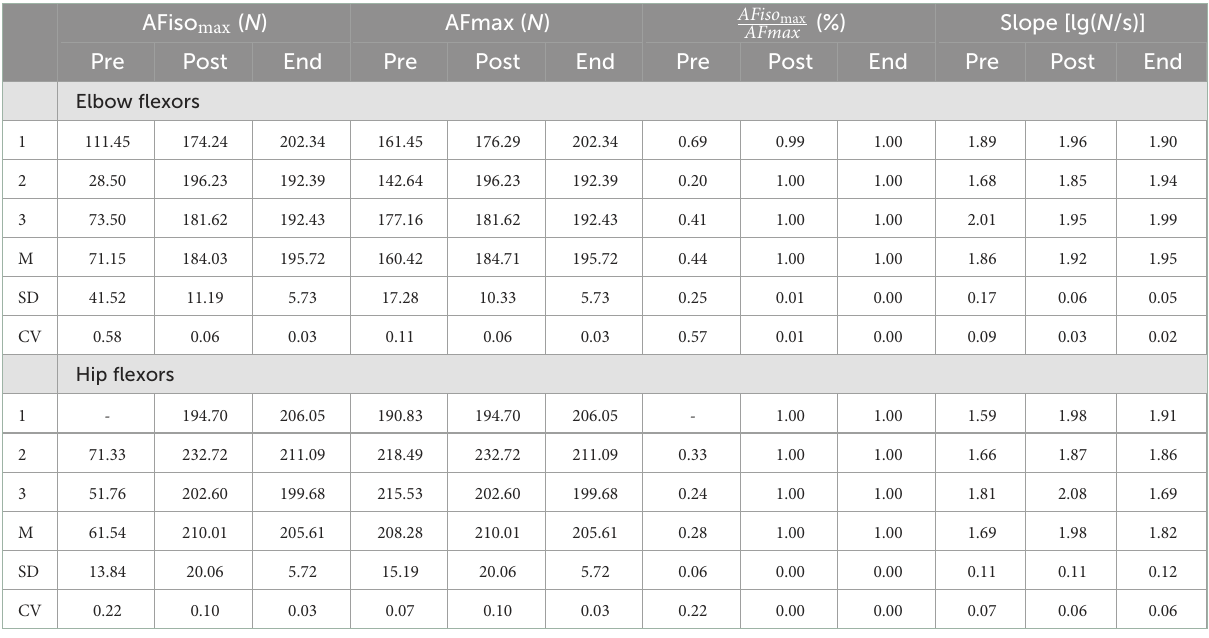
TABLE 1 Results of Adaptive Force (AF) of left elbow and hip